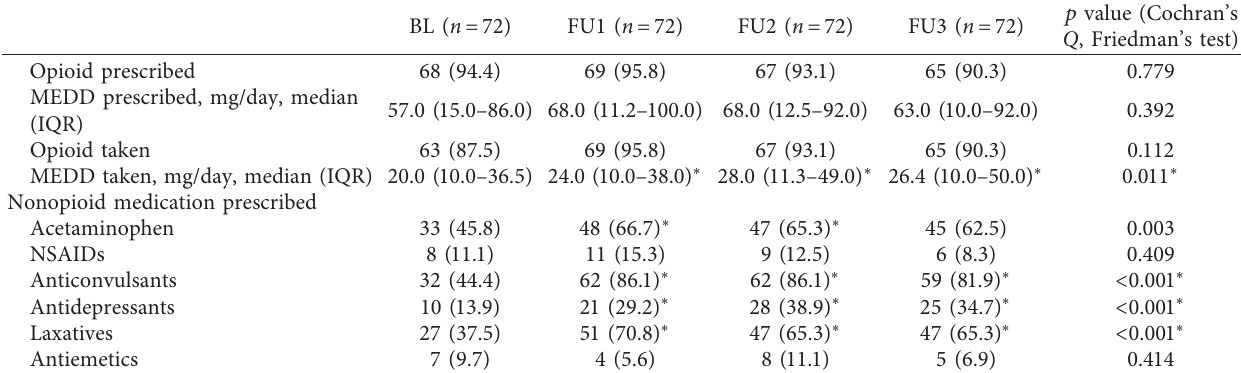
Table 5: Opioid prescription pain medication taken in completed follow-up patients.